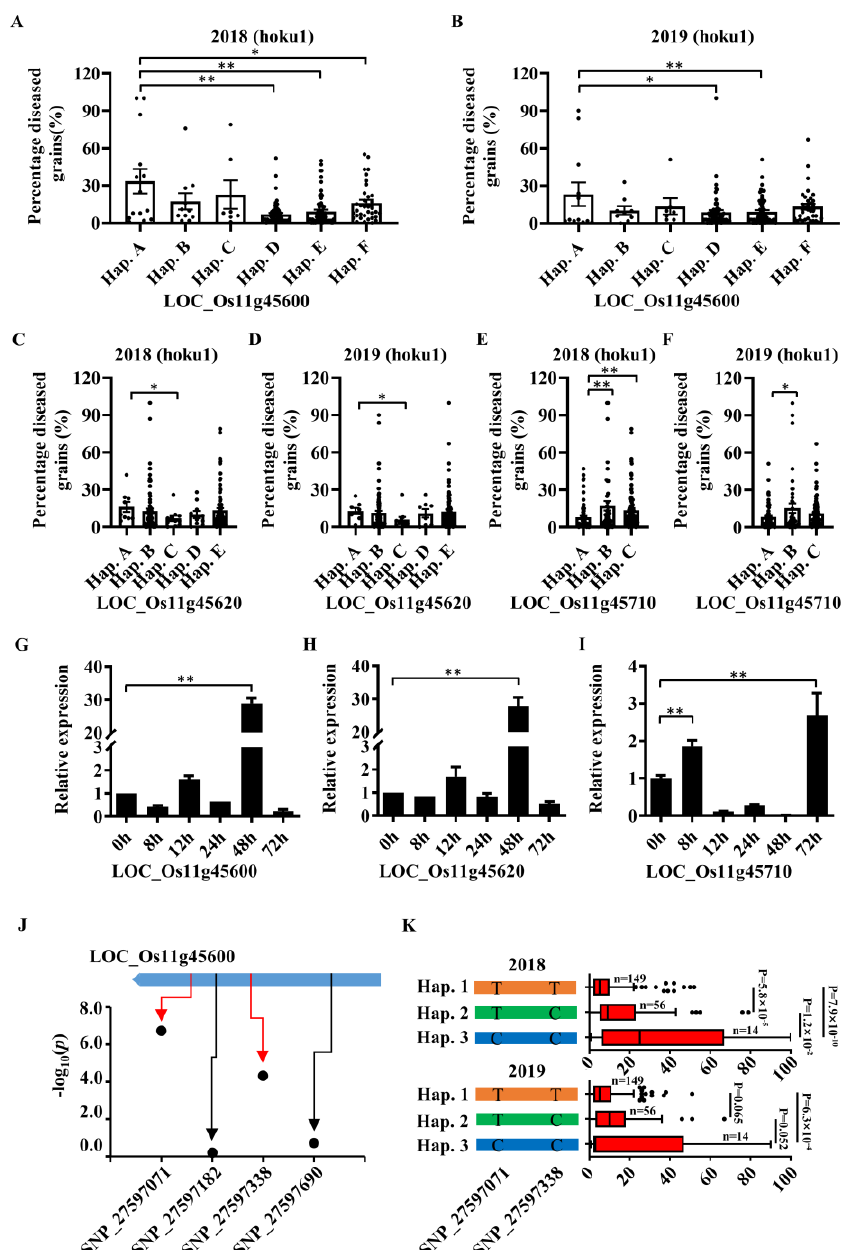
Figure 3. Genes with significant haplotype differences are induced by Magnaporthe oryzae . ( A – F ) Percentage diseased grains (%) caused by different haplotypes. Presented as a scatter plot with bars, the edge of the box represents the mean, and each point represents the percentage diseased grains for a germplasm. ( G – I ) The expression patterns of candidate genes (LOC_Os11g45600, LOC_Os11g45620 and LOC_Os11g45710) in the disease-resistant material Jiangnanwan inoculated with M. oryzae Hoku1 were studied by qPCR. The amplification of OsActin1 (LOC_Os03g50885) was used as an internal reference. Error bars are the standard deviation of three technical replicates. ( J ) Location of all SNPs on LOC_Os11g45600 and their correlation with trait variation. Significant ( − Log 10 P ≥ 4) SNP positions are marked with red arrow lines. ( K ) Haplotype analysis of two significant SNPs on LOC_Os11g45600; the “n” represents the number of rice varieties in the population. Results are represented as the mean ± SEM; (* p < 0.05, ** p <